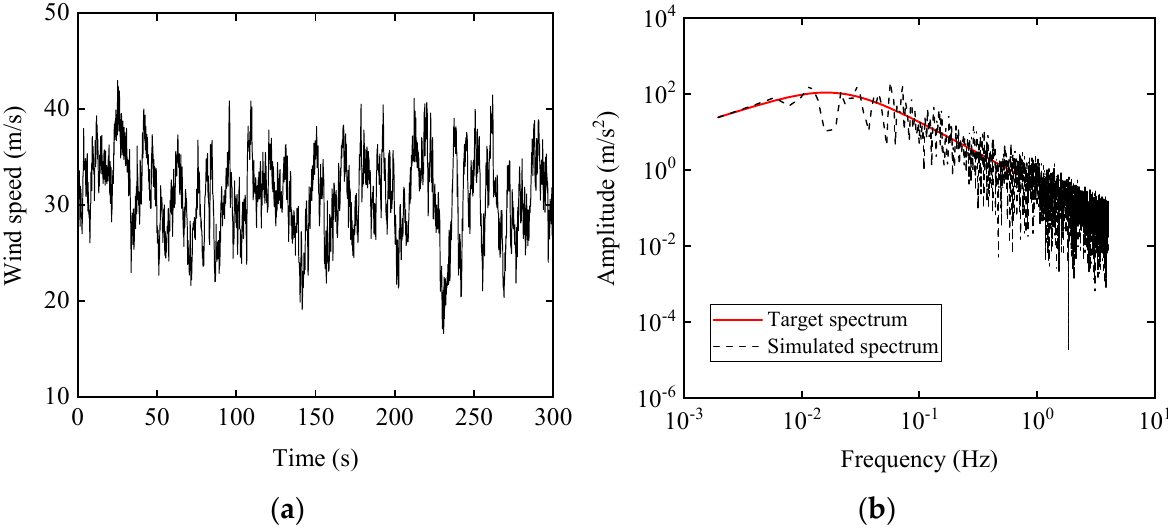
Figure 7. Simulated wind speed results. ( a ) Wind speed at the top of the tower. ( b ) Comparison of the simulated and target spectrum.